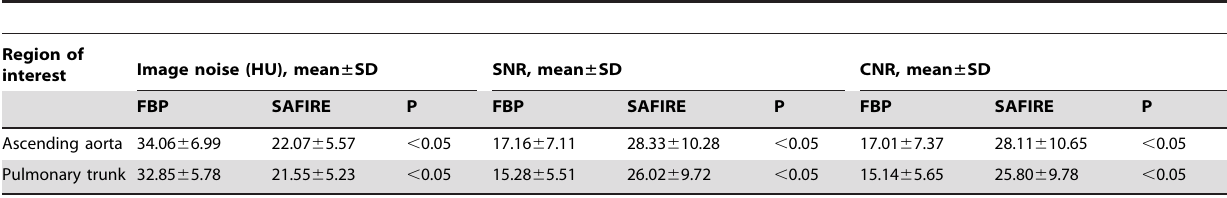
Table 3. Image noise, signal-to-noise ratio (SNR) and contrast-to-noise ratio (CNR) in filtered back projection (FBP) and sinogram affirmed iterative reconstruction algorithm (SAFIRE) series at 70 kVp dual-source CT (DSCT) angiography.